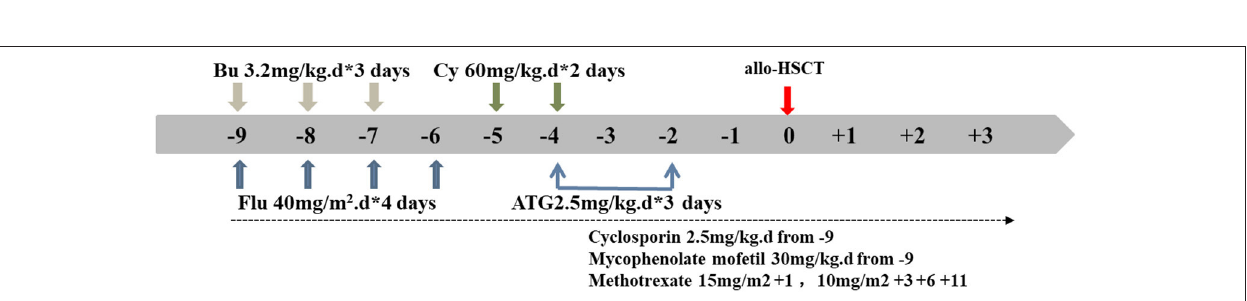
3 months. The last follow-up date was on April 28th, 2021, 2 years post-transplantation. The patient recovered well, with no abnormal manifestations or transplant-related